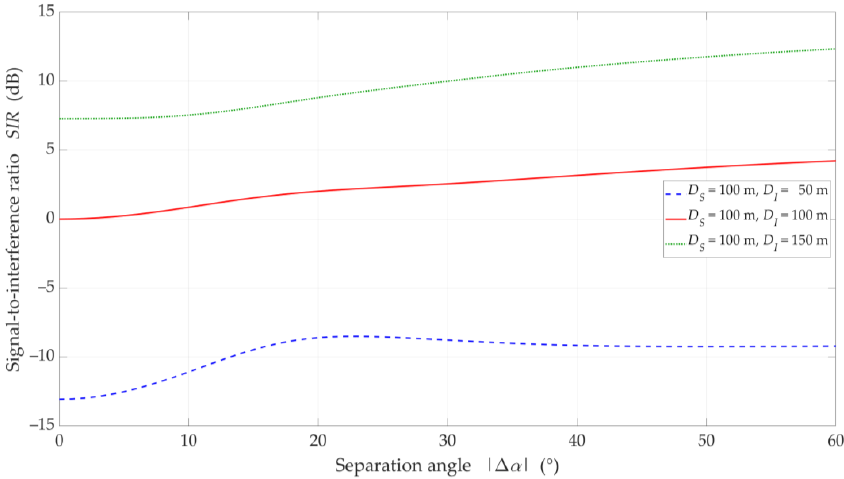
Figure 11. SIR versus separation angle for UL scenario, selected D I = {50, 100, 150} m, D S = 100 m, and NLOS (TDL-B) conditions.